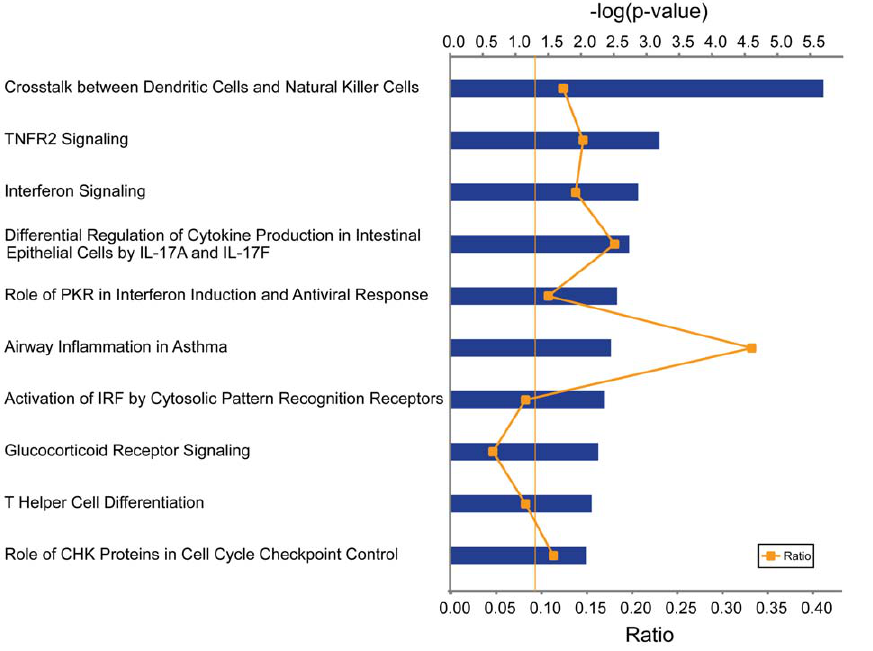
diluent- and allergen-challenged (D and A) CD4 + T cells from 21 allergic patients (Test1) while the other one consisted of CD4 + T cells challenged with allergen (A), or allergen + GC (T) from 28 allergic patients (Test2). Because of the large number of genes